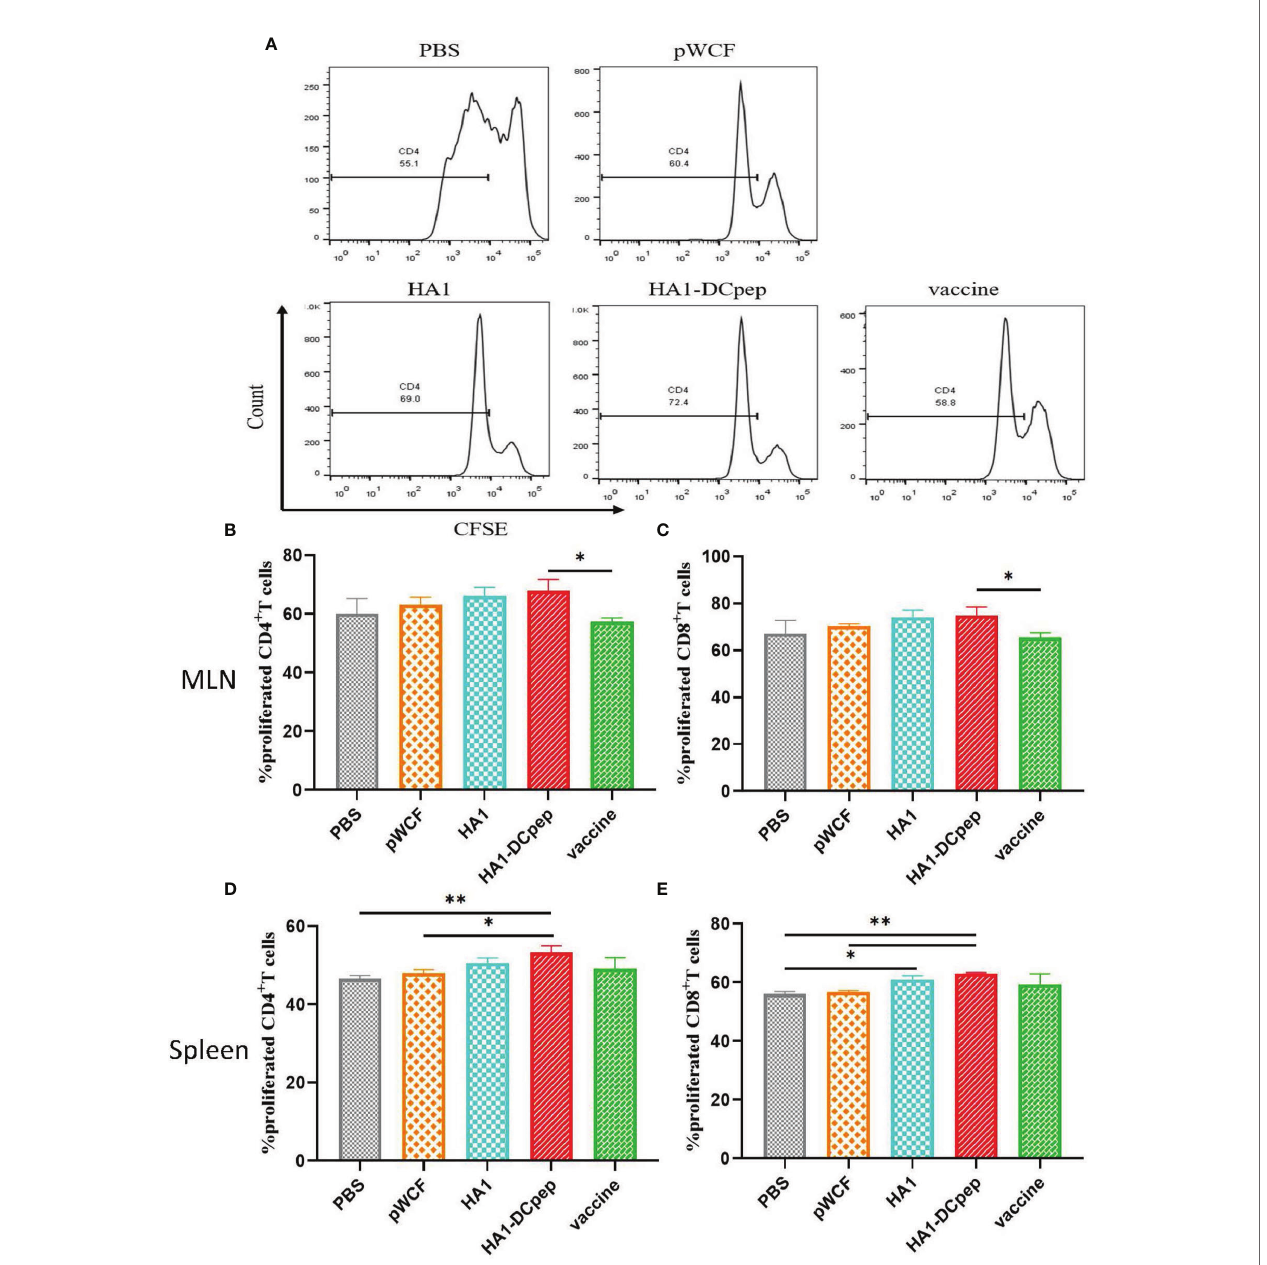
FIGURE 4 | Effect of recombinant L. plantarum on T cell proliferation. After booster immunization, mice MLNs cells and splenocytes were stained with CFSE and subsequently cocultured in 96-well U-bottom plates with speci fi c antigenic peptides for 3 days. The number of CD4 + IFN- g + T cells in the MLNs in different groups is displayed (A) . The proliferation of CD4 + T cells (B) and CD8 + T cells (C) in the mice MLNs and that of CD4 + T cells (D) and CD8 + T cells (E) in the spleen were examined. Statistical signi fi cance was assessed by one-way ANOVA (n = 3 mice per group). *P < 0.05; **P <